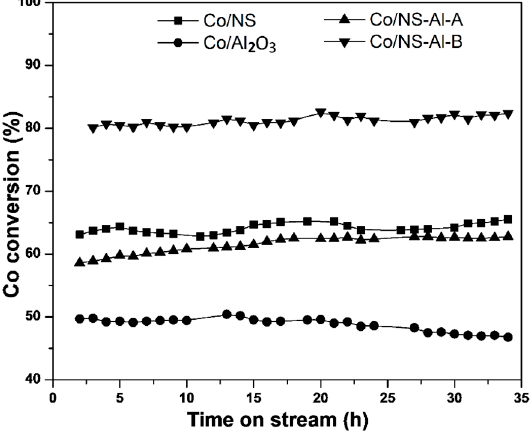
Figure 11. CO conversion as a function of the time on stream for the calcined Co / NS, Co / Al 2 O 3 , Co / NS-Al-A and Co / NS-Al-B catalysts.